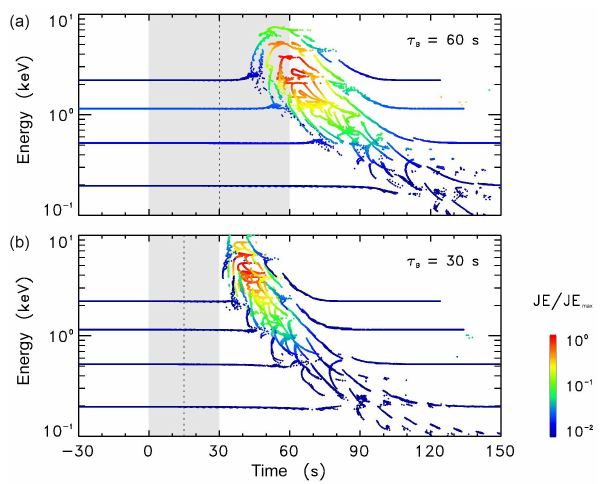
Figure 11. Computed H + energy–time spectrograms for two differ- ent reconfiguration timescales (60 and 30s in top and bottom panels, respectively). The normalized energy flux is coded according to the color scale on the